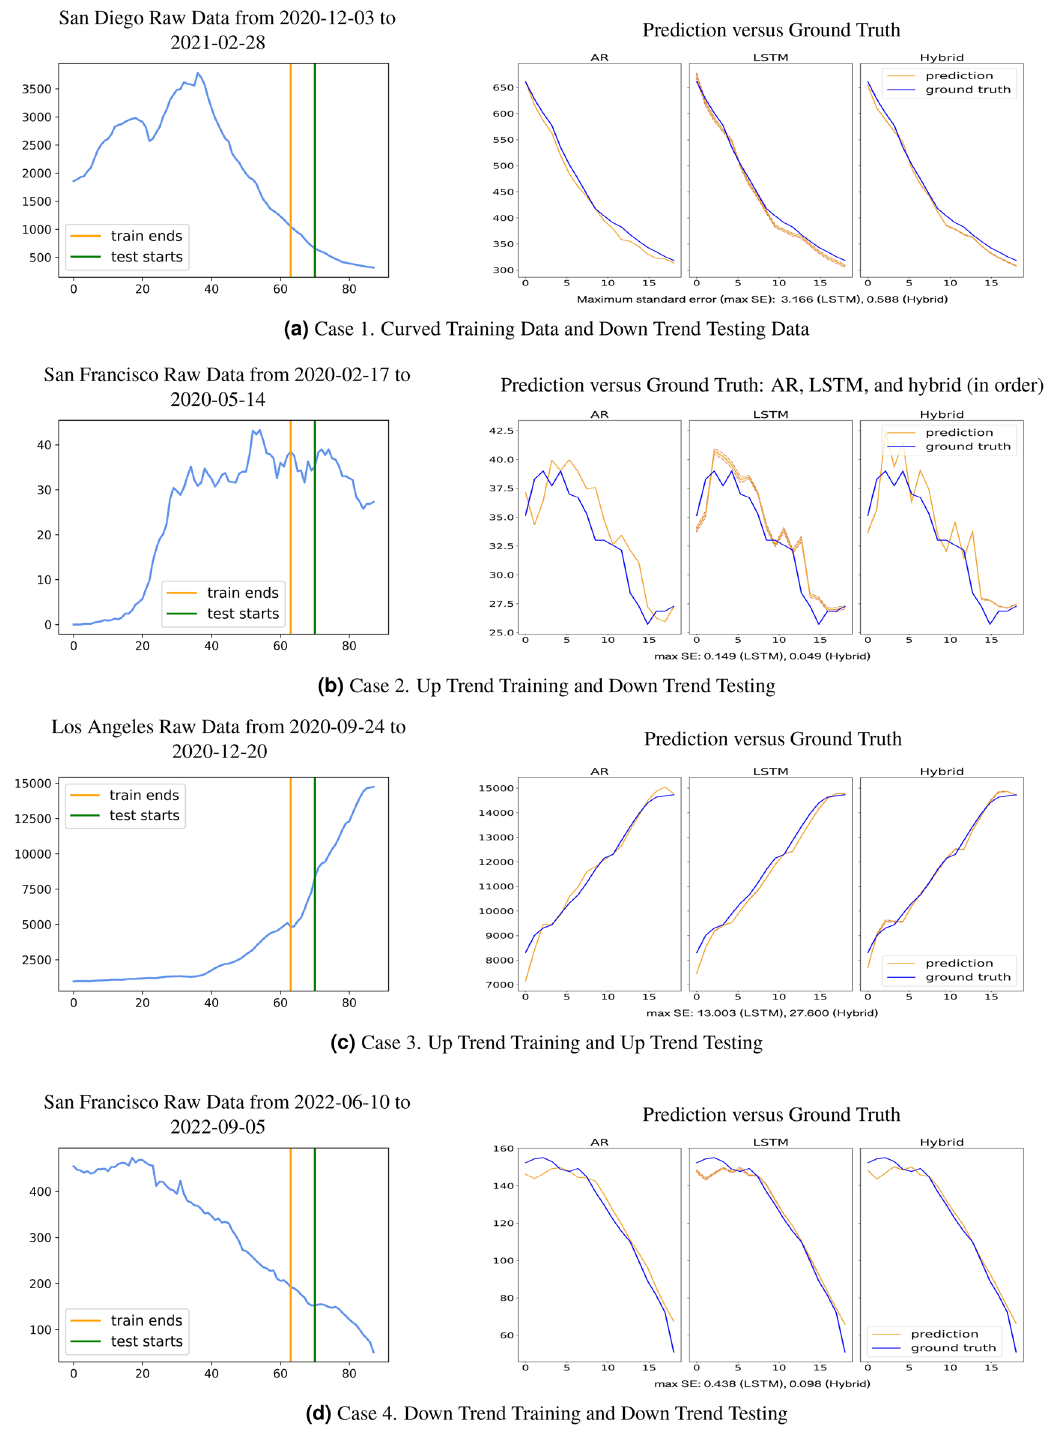
Figure 3. The left panels show the training and testing data. The right panels show the ground truth versus forecasts of the AR, LSTM, and hybrid model, respectively. We display the average prediction (solid line) with 2 times standard error (shaded region). The standard error across 100 runs are reported for LSTM and hybrid. The hybrid model is more stable than the